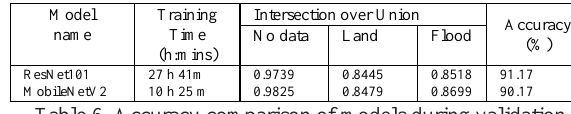
Table 6. Accuracy comparison of models during